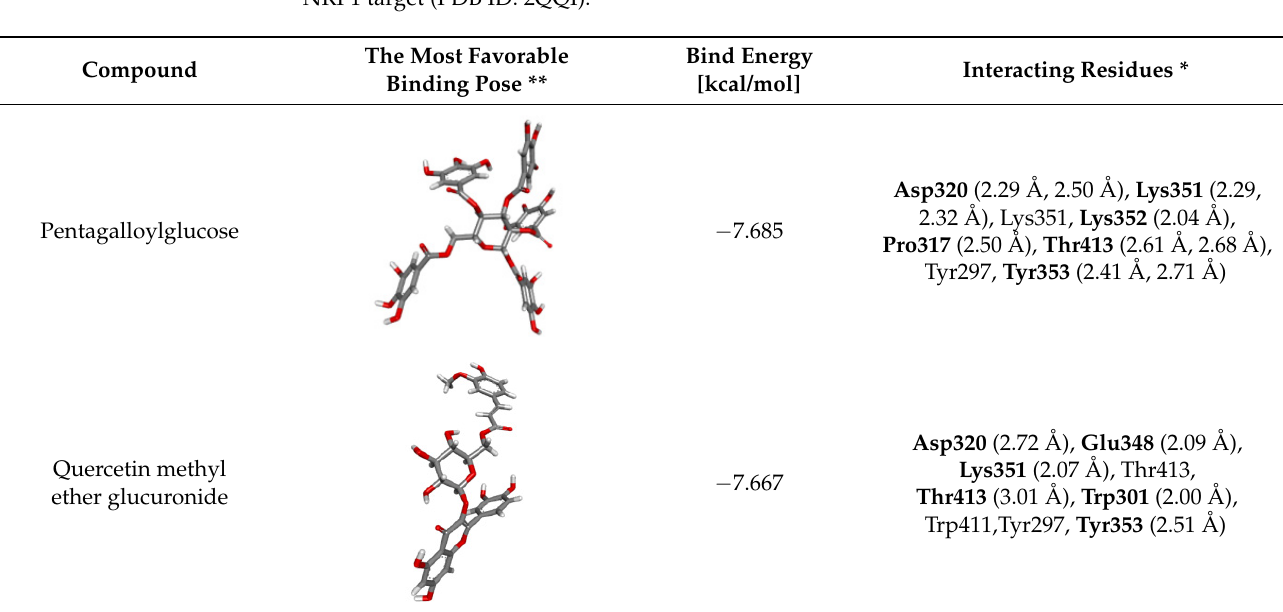
Figure 4. Binding energy (kcal/mol) curves for A. viridiflora constituents and positive controls against all tested S-glycoprotein structural variants. Table 3. Molecular docking simulation results of A. viridiflora constituents and positive control against NRP1 target (PDB ID: